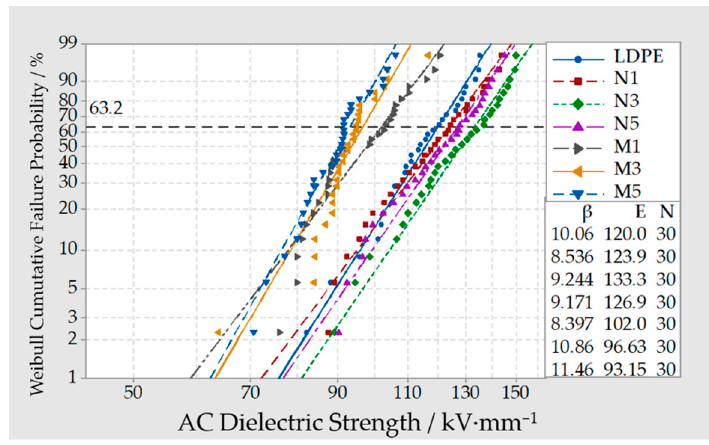
Figure 6. Weibull distribution curve of LDPE, different Micro-ZnO/LDPE, and Nano-ZnO/LDPE composites.